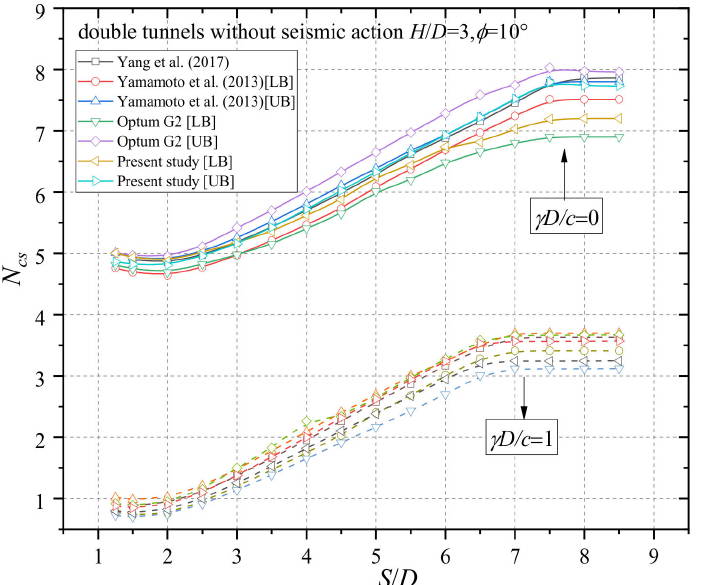
Figure 3. Comparison of N cs -S / D curves with different γ D / c for double tunnels without seismic action.